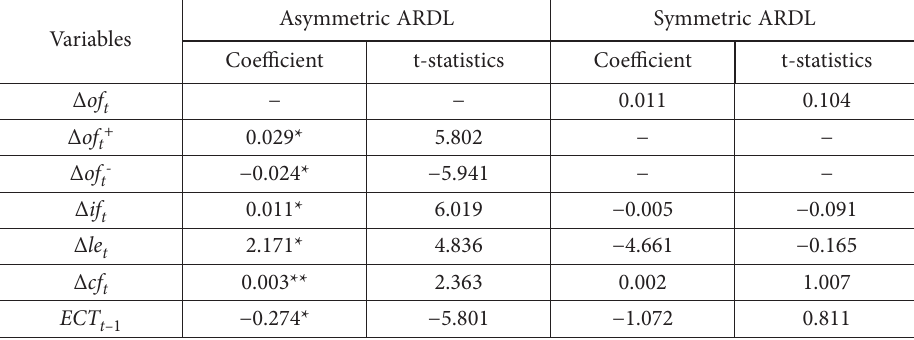
Table 5. Short run estimation results of symmetric and asymmetric ARDL models Variables